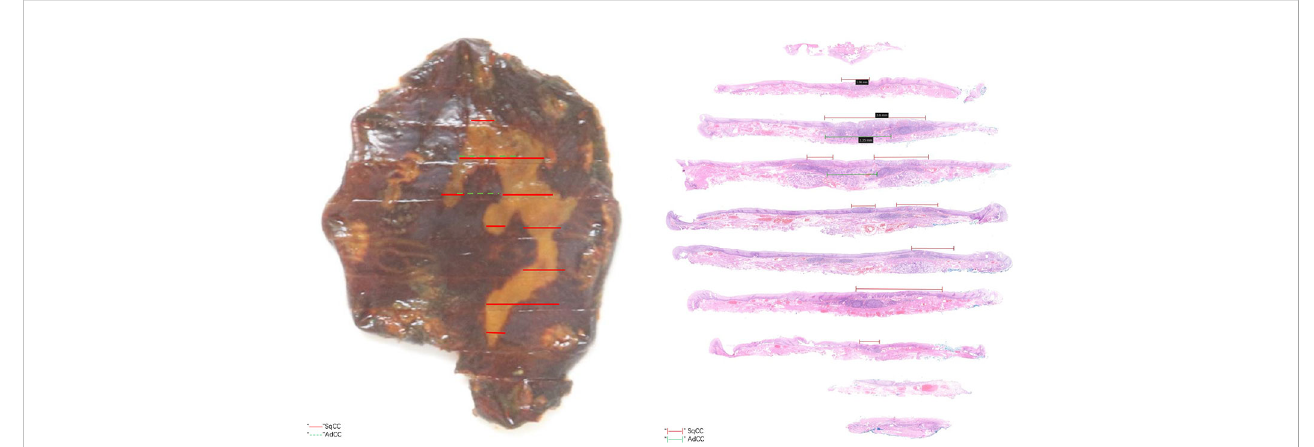
FIGURE 2 Translucent observation of the lesion and microscopic appearance of the